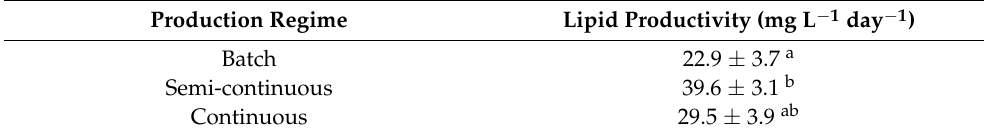
Table 4. Global lipid productivity in the cultivation of Nannochloropsis oceanica , for each of the operation regimes in 2.6 m 3 PBRs. The values represent the average and standard deviation of three biologically independent replicates. Different letters within the same column represent significantly different values ( p -value <